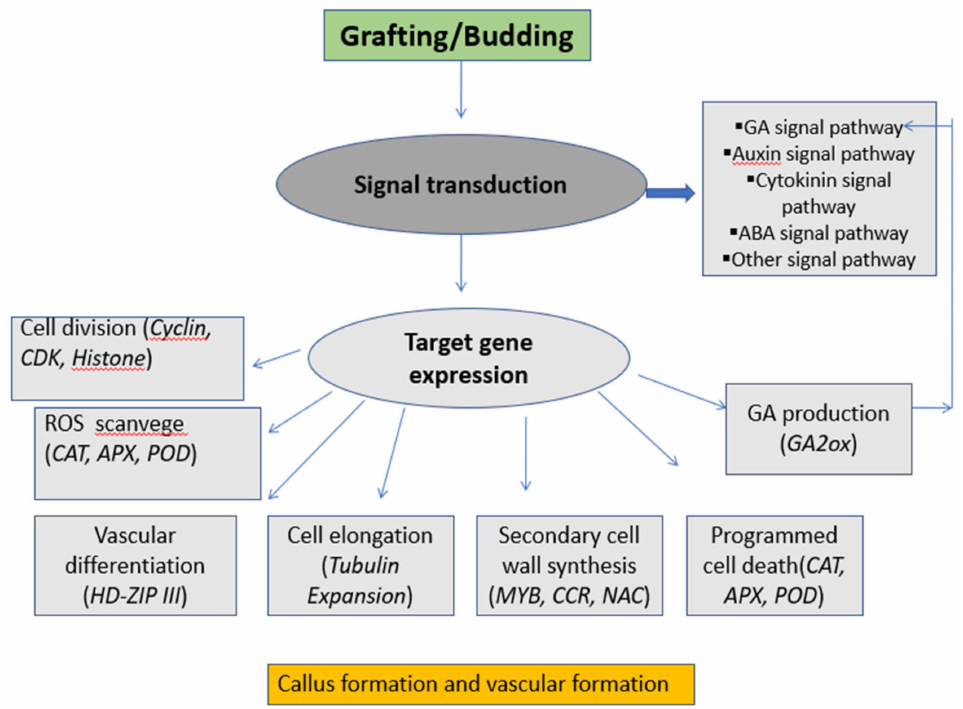
Figure 2. Signal transduction mechanisms during callus and vascular tissue formation using various hormones and enzymes. Mechanism of signal transduction via different pathways and differentially expressed genes explain the key role of hormones and genes in callus formation during grafting and budding. Table 2. Function of phytohormones encoding genes in graft compatibility in various fruit